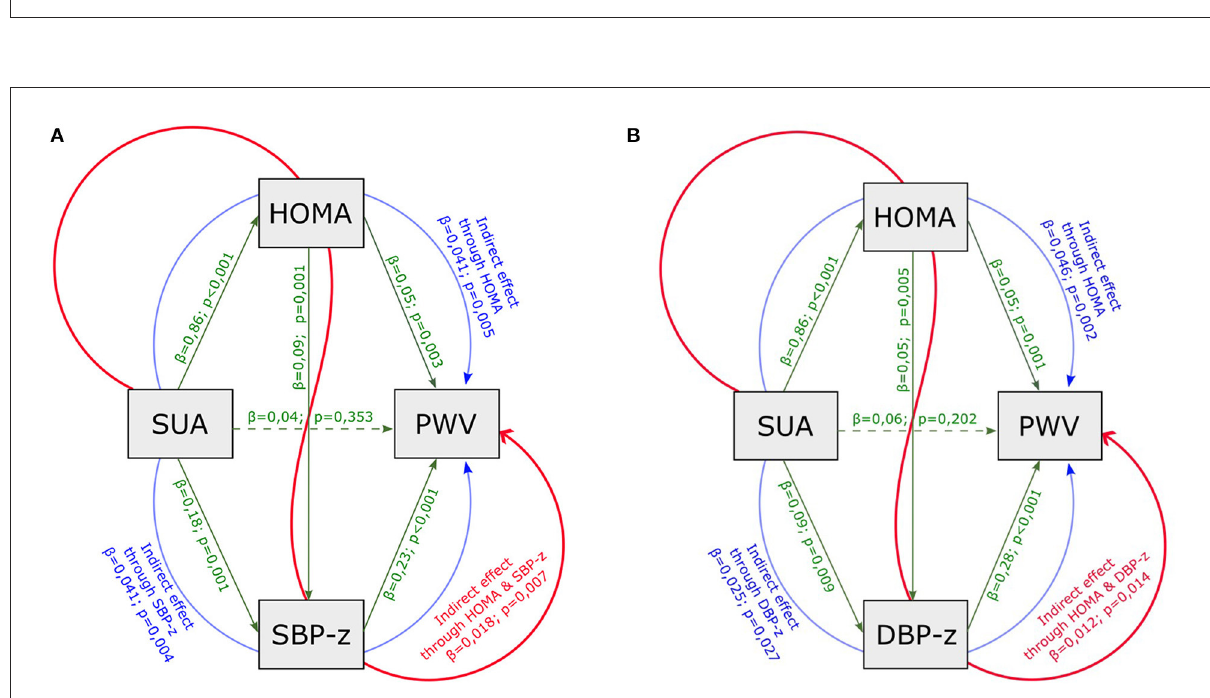
FIGURE2 Mediation analysis model with PWV as outcome, including HOMA-index, SUA, SBP (A) and DBP (B) z- scores as mediators. SUA, serum uric acid; HOMA-index, homeostatic model assessment index; PWV, pulse wave velocity; eGFR, estimated glomerular filtration rate; SBP-z, systolic blood pressure z- score; DBP-z, diastolic blood pressure z- score. Continuous line, statistically significant; dotted line, not statistically significant; green line, direct effect; blue line, partial indirect effect (one mediator); red line, partial indirect effect (two mediators). Overall indirect effect (with SBP z) = 0,100 p < 0,001. Overall indirect effect (with DBP z) = 0,084 p <